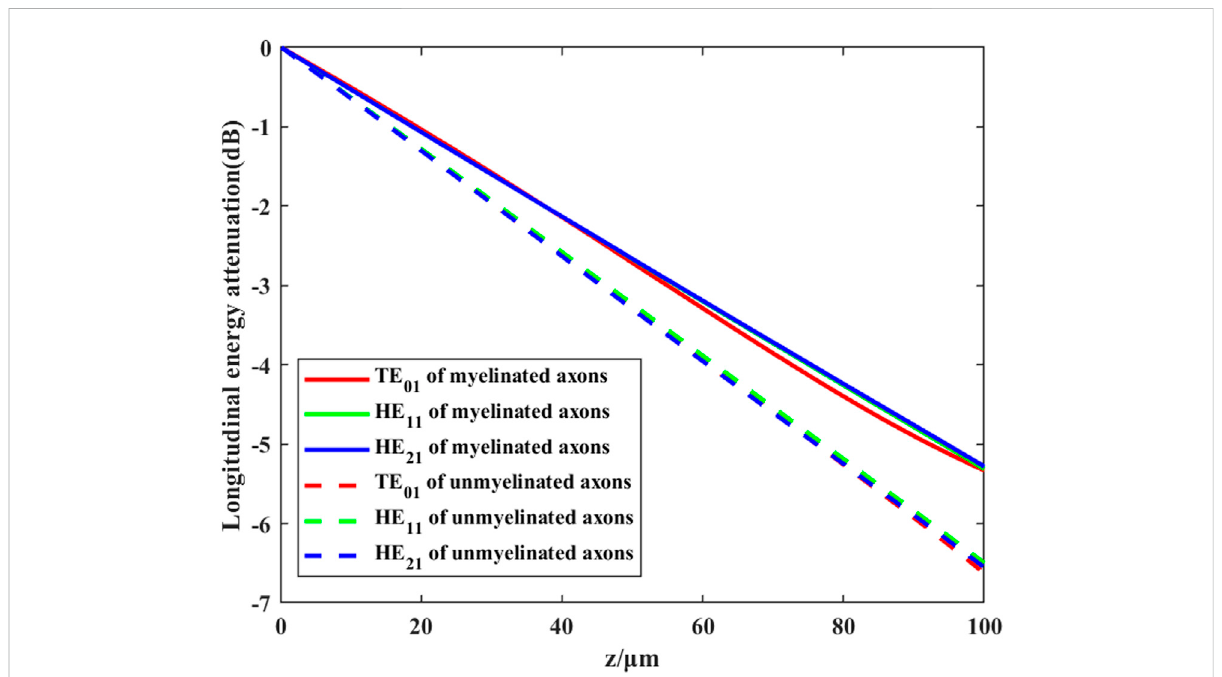
FIGURE 7 Transmission ef fi ciency of different modes of THz-FIR waves in myelinated and unmyelinated nerve fi bers at f = 30 THz.